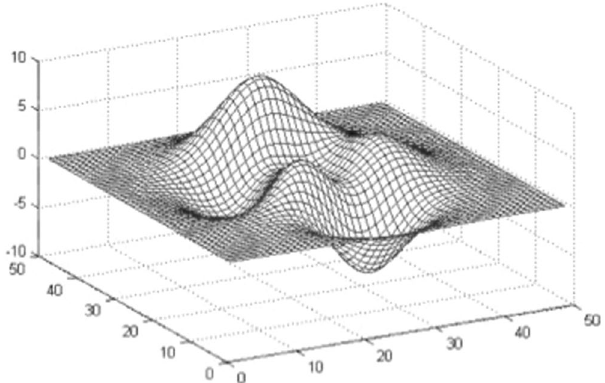
Figure 2. Typical constrained data set with dynamic